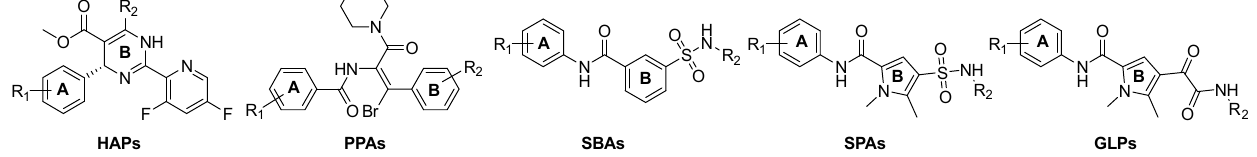
Figure 1. Major chemical classes of CpAMs. Common ring features are labelled as A and B .